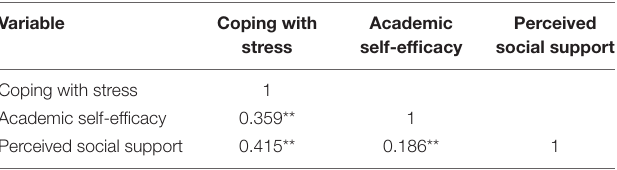
TABLE 3 | Correlation between coping with stress, academic self-efficacy, and perceived social support.